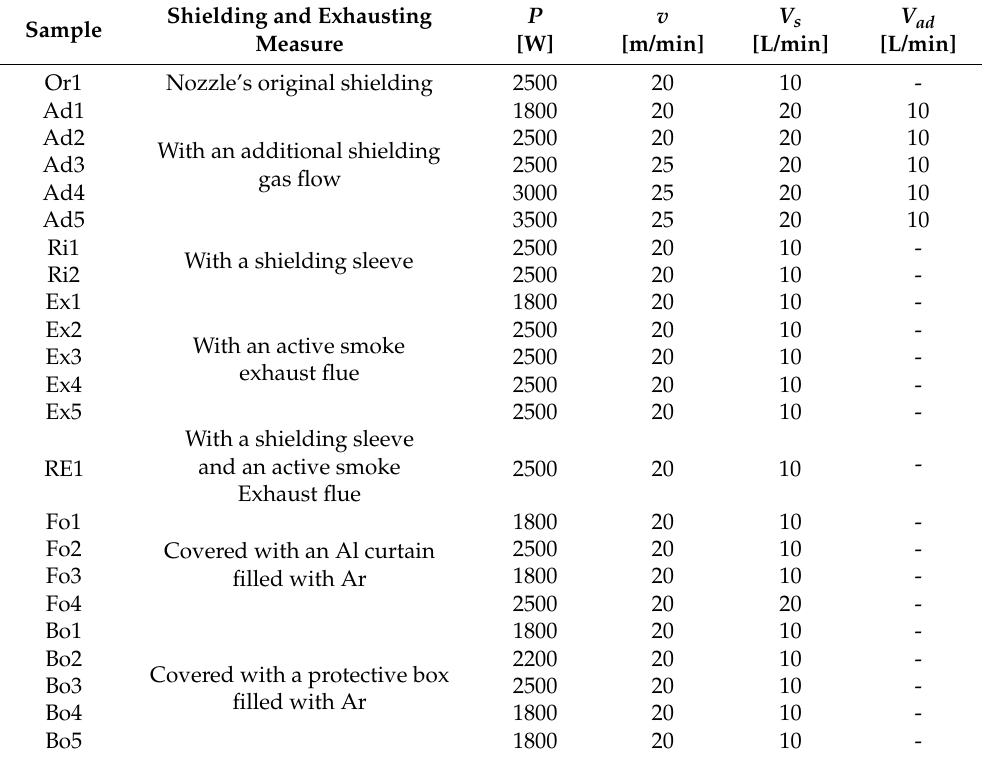
Figure 5 . Exterior views of specimens of ( a ) single tracks, ( b ) 3D-parts with about 5 mm height and used for hardness tests, and ( c ) 3D-parts with about 50 mm height and used for tensile tests. The black bars indicate a length of 50 mm. Table 1. Parameter sets of laser power P , travel speed v , nozzle’s own shielding gas flow rate V s , additional shielding gas flow rate V ad . and shielding and exhausting measures for fabricating 3D-